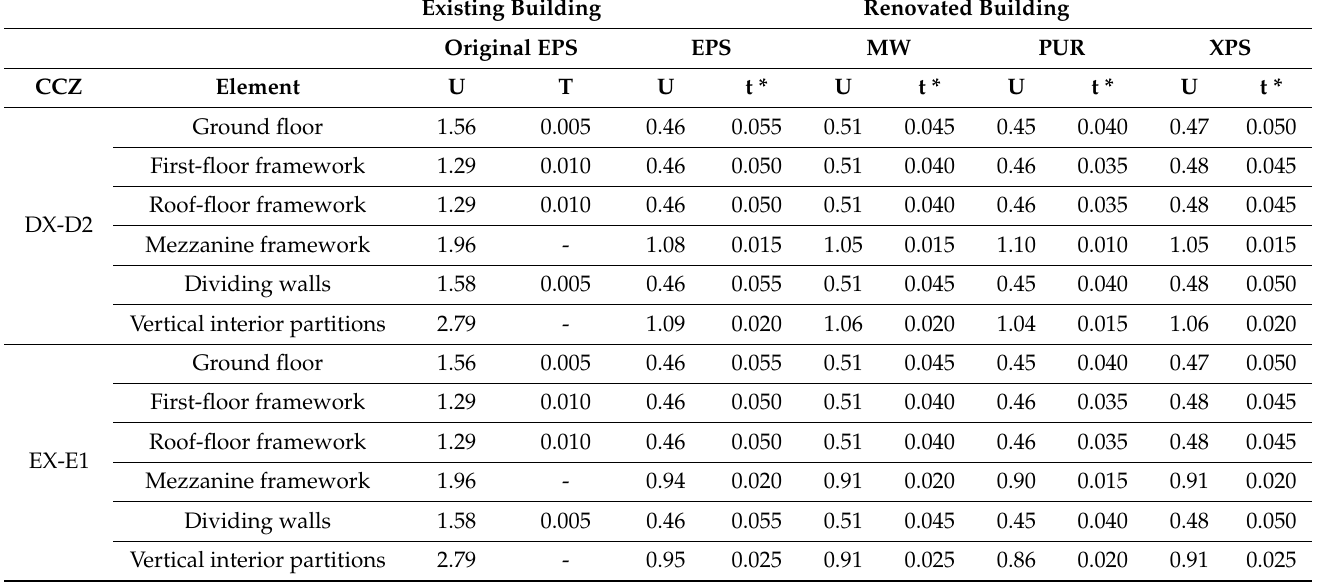
Table 4. Thermal transmittances (U), in W/m 2 · K, and thicknesses of thermal insulation material (t), in m, for ground floor, first-floor framework, roof-floor framework, mezzanine framework, dividing walls and vertical interior partitions of the existing and renovated building by